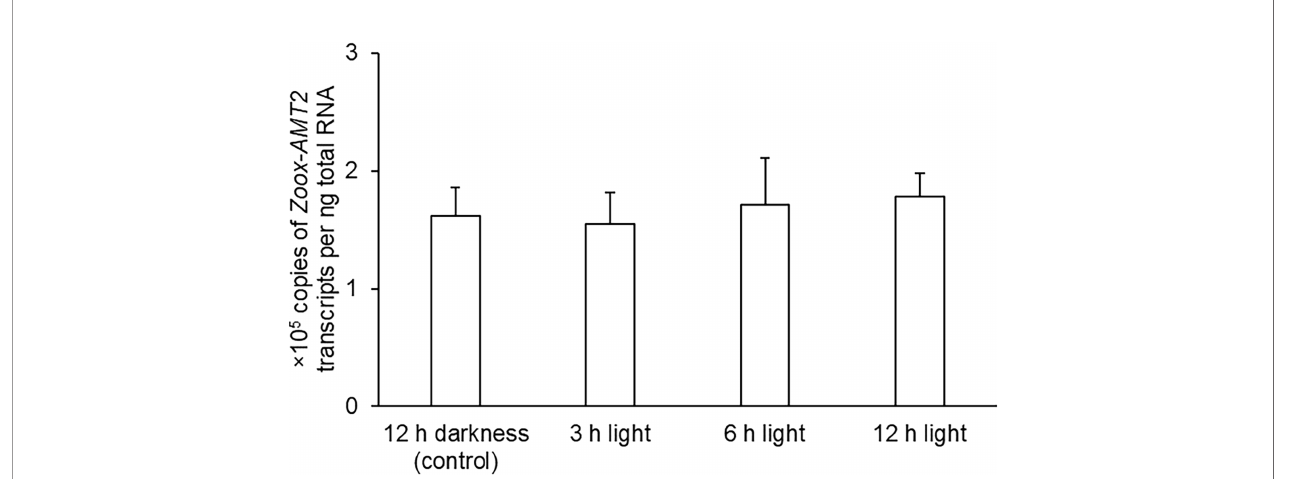
FIGURE 5 | Effects of light on the transcript levels (×10 5 copies of transcripts per ng total RNA) of zooxanthellae-ammonium transporter 2 ( Zoox - AMT2 ) in the outer mantle of Tridacna squamosa exposed to darkness for 12 h (control) or to light for 3 h, 6 h, or 12 h. Results represent means + SEM (n = 4). Means not sharing the same letter are signi fi cantly different (p-value <